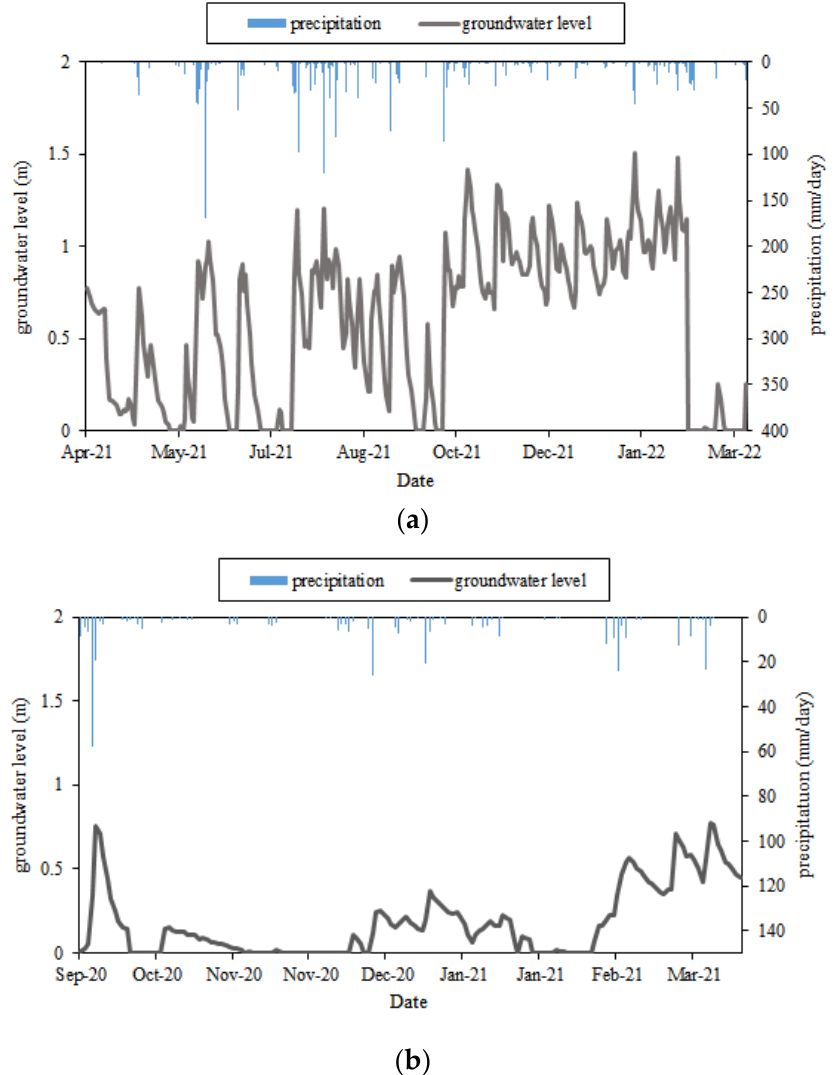
Figure 5. Groundwater level at ( a ) the permeable pavement site and ( b ) the raingarden site. The rising groundwater level with rainfall implied the recharge potential of the sites, but the groundwater level was also affected by the area outside the site such that the actual recharge amount could not be obtained by the measurement.